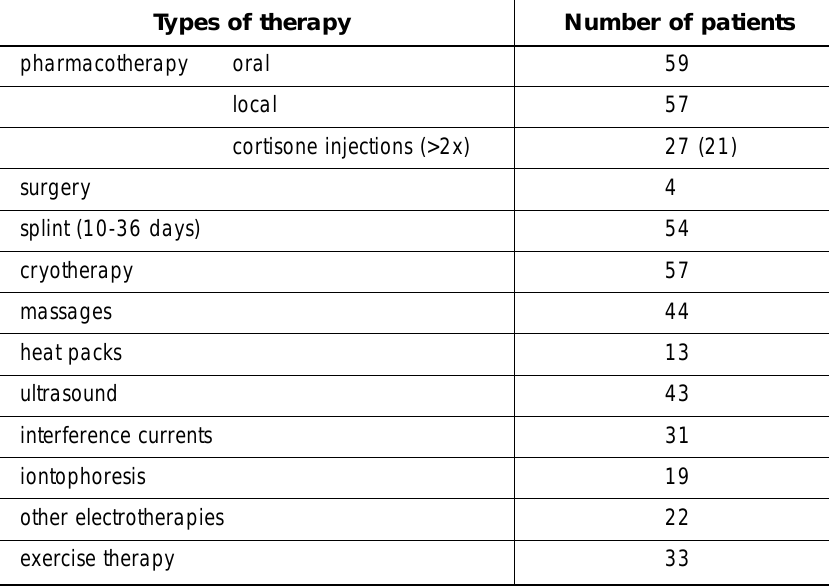
Table 1: Types of prior treatments in the total patient population (n=60)